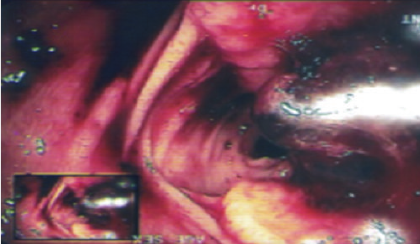
Figure 4: Colonoscopy. Friable and bleeding tumor in the colon hepatic flexure, obstructing the lumina.